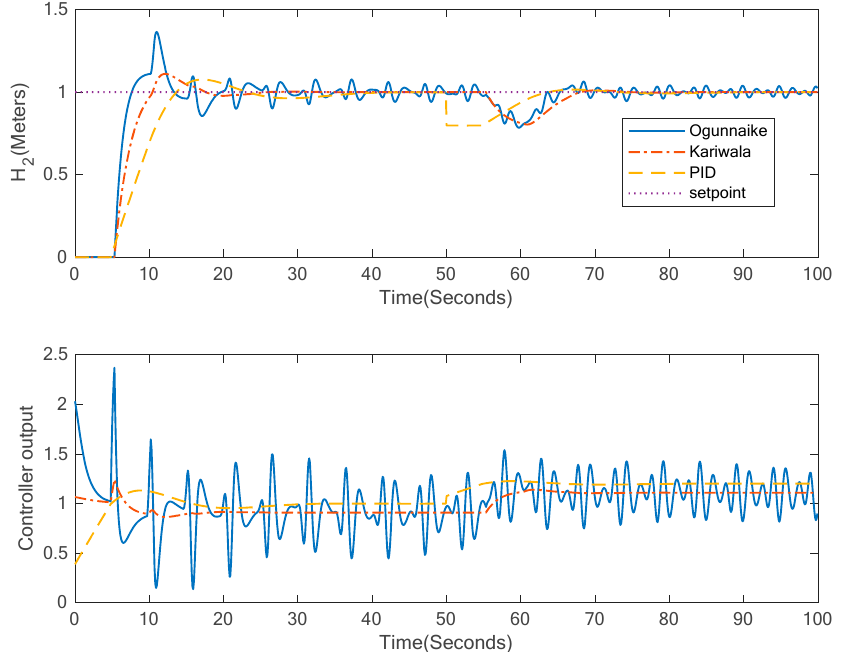
Figure 14. Example 1: Regulatory response with the RTD-A controller using tuning rules and proportional integral derivative (PID).